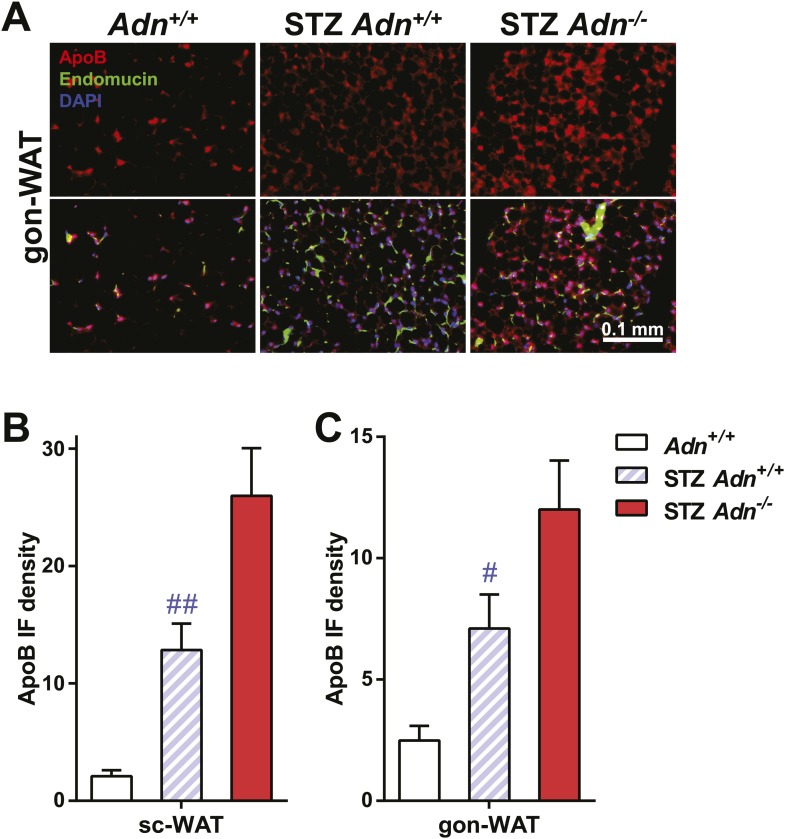
ApoB immunofluorescence in gonadal WAT with quantitation.(A) Representative co-immunofluorescence of apolipoprotein B (ApoB, red) and endomucin (green) on gonadal WAT. (B and C) Quantitation of ApoB immunofluorescence intensity volume normalized against tissue area in subcutaneous WAT (B) and gonadal WAT (C). n ≥ 3 mice per condition. Data are presented as the mean ± SEM. #p < 0.05, ##p < 0.01 for STZ-treated vs untreated Adn+/+. Related to Figure 3F.